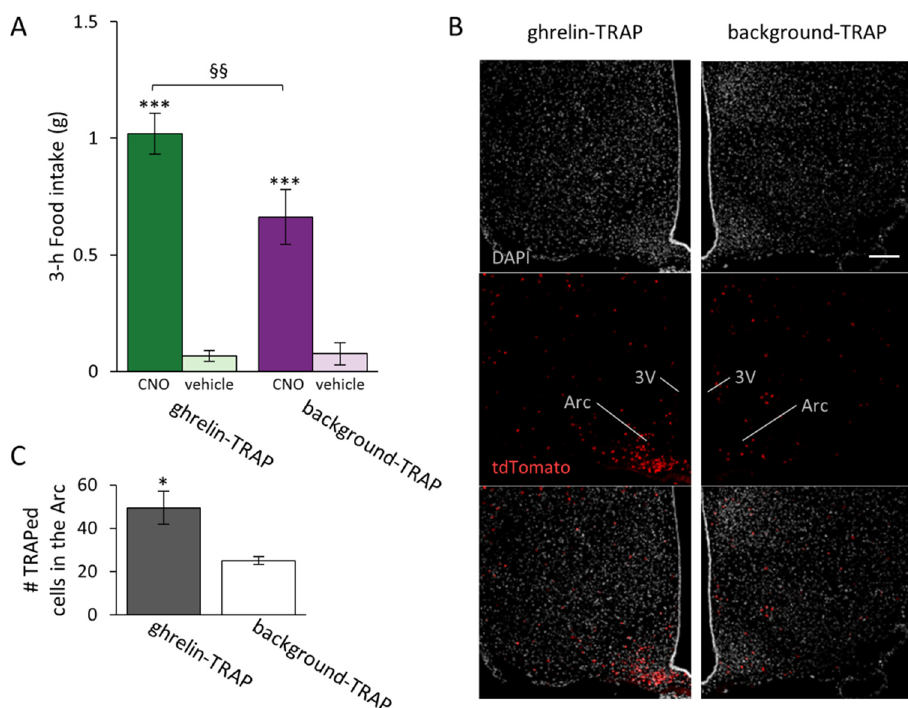
Figure 2. Clozapine-N-oxide (CNO)-induced food intake is greater in the ghrelin-TRAPed group than in the background-TRAPed group. ( A ) The ghrelin-TRAPed group (n = 13) and background-TRAPed group (n = 8) were injected with 1 mg/kg CNO or a vehicle in a cross-over design. Symbols represent: *** p < 0.001 (1 mg/kg CNO vs. vehicle); §§ p < 0.01 (ghrelin-TRAP + CNO vs. background-TRAP + CNO); ( B ) Representative fluorescence images of TRAPed cells (tdTomato + ) in ghrelin-TRAPed and background-TRAPed groups. Scale bar: 100 µm, applicable to all six panels; ( C ) Number of TRAPed cells (tdTomato + ) in the arcuate nucleus (Arc) in the ghrelin-TRAPed (n = 5) and background-TRAPed (n = 4) groups. * p < 0.05. Error bars represent ± SEM. Third ventricle: 3V.